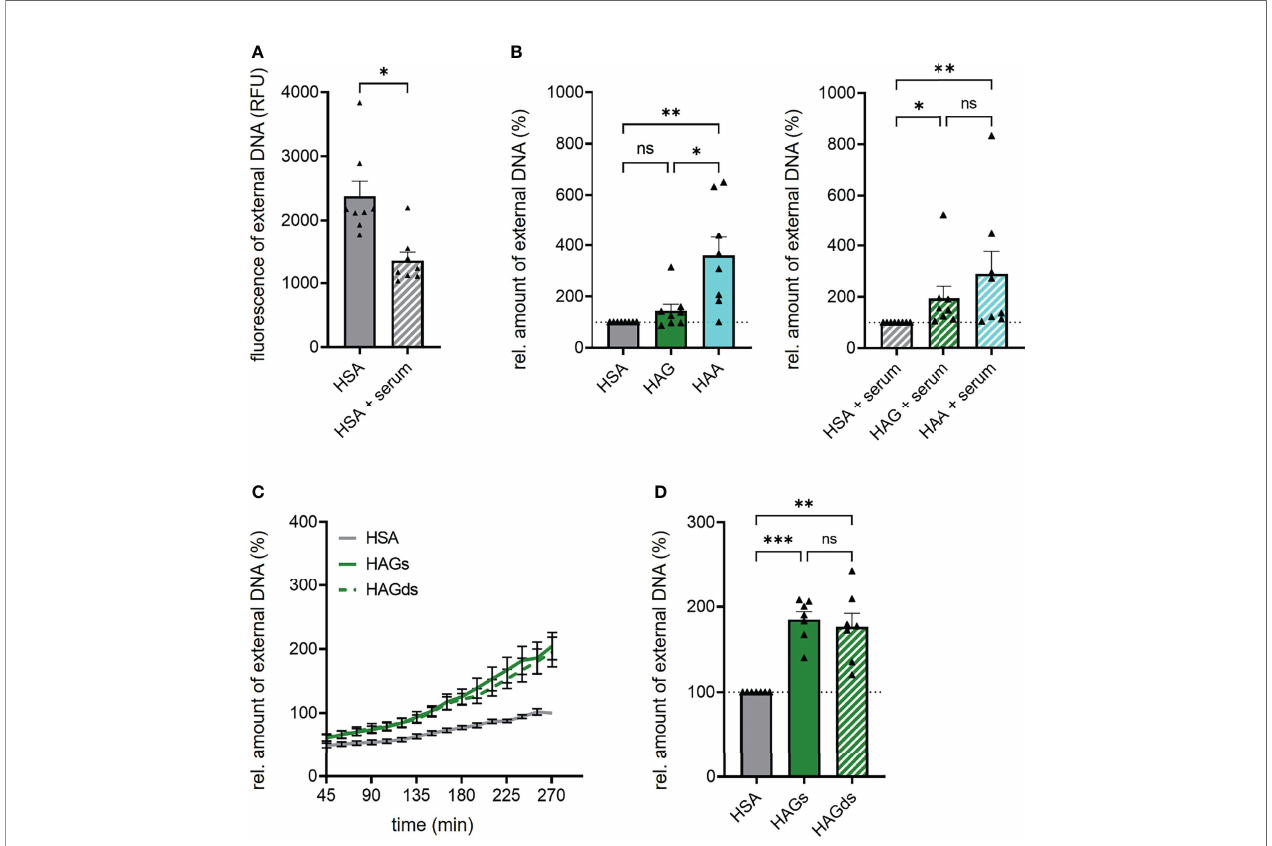
FIGURE 4 | Autologous serum and sialylation status do not in fl uence IgG complex-induced NET formation. (A) Spontaneous NET formation of isolated human neutrophils in the presence of 150 µg/ml human serum albumin (HSA) with or without 2% autologous serum. NET formation was measured by staining extracellular DNA with Sytox Green. Shown is fl uorescence intensity of Sytox Green 270 min after HSA addition. N = 8 donors. (B) NET formation of human neutrophils with 150 µg/ml heat-aggregated IgG (HAG), heat-aggregated IgA (HAA) or human serum albumin (HSA) in the absence or presence of 2% autologous serum. Shown are relative amounts of extracellular DNA 270 min after stimulation normalized on HSA treatment. The dashed line represents the relative amount of NETs of the HSA treated control. N = 8 donors. (C, D) NET formation of human neutrophils with 150 µg/ml heat-aggregated native IgG (HAGs), heat-aggregated desialylated IgG (HAGds) or human serum albumin (HSA). (C) NET formation over time. (D) Relative amounts of extracellular DNA 270 min after stimulation normalized on HSA treatment. The dashed line represents the relative amount of NETs of the HSA treated control. N = 7 donors. Data are presented as mean ± SEM (C) or scatter plots with bars showing mean and SEM (A, B, D) . Signi fi cance was tested with Wilcoxon matched-pairs signed rank test (A) repeated measures one way ANOVA with Geisser Greenhouse correction and S ̌ ı ́ da ́ k ’ s multiple comparisons post hoc test (D) or Friedmann test followed by Dunn ’ s multiple comparisons test (B) post hoc . *p < 0.05; **p < 0.01; and ***p < 0.001. ns, not signi fi